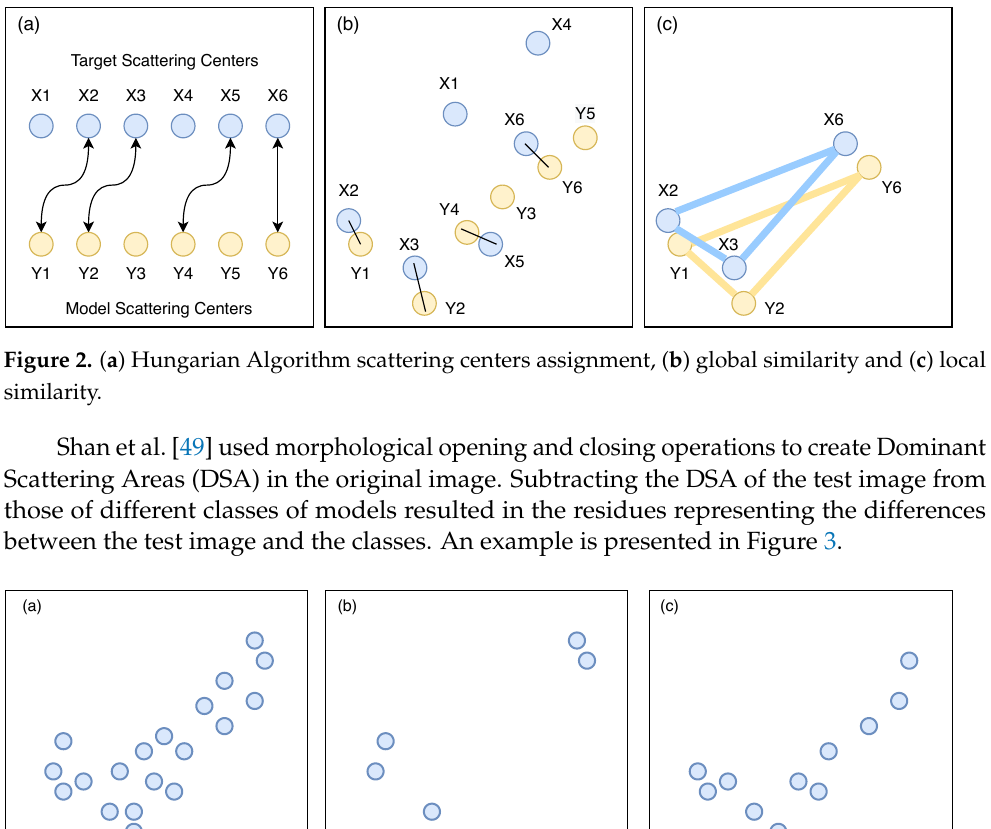
triangular structures of scattering centers to identify local similarities, as shown in Figure 2.